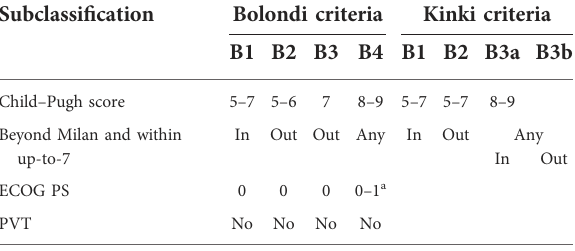
TABLE 1 Subclassi fi cation of BCLC B stage hepatocellular carcinoma. Subclassi fi